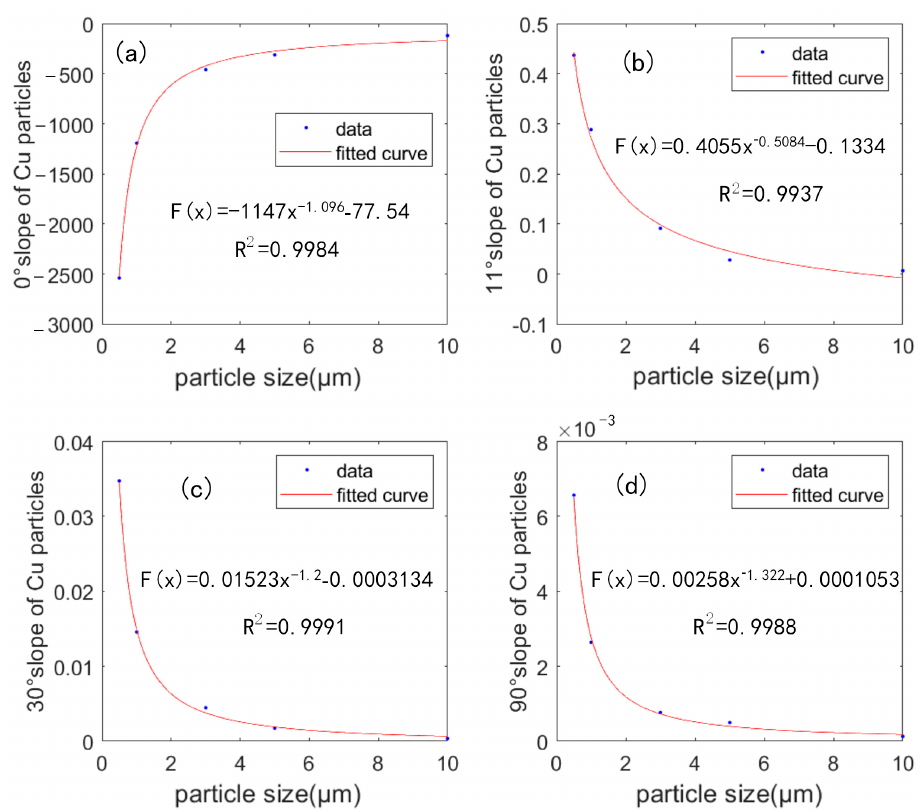
Figure 16. The fitting drawing between slope and particle size of copper particles with different sizes measured at ( a ) 0° ( b ) 11° ( c ) 30° and ( d ) 90°.